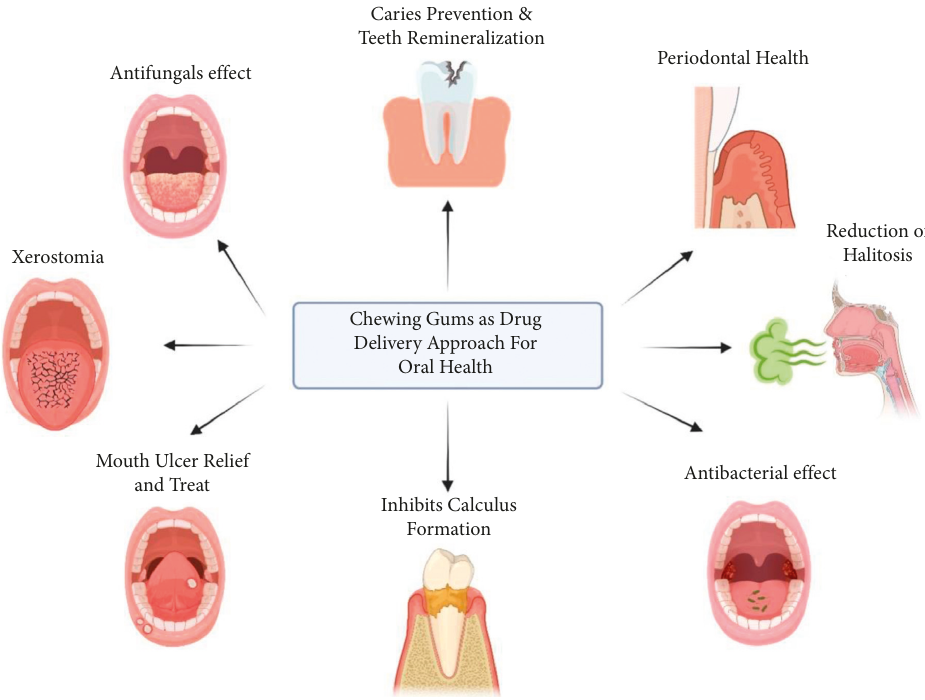
Figure 3: Chewing gums as a drug delivery approach for oral